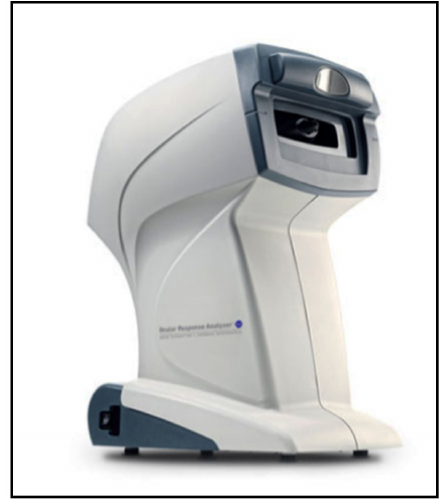
Figure 7. Ocular Response Analyzer (ORA)